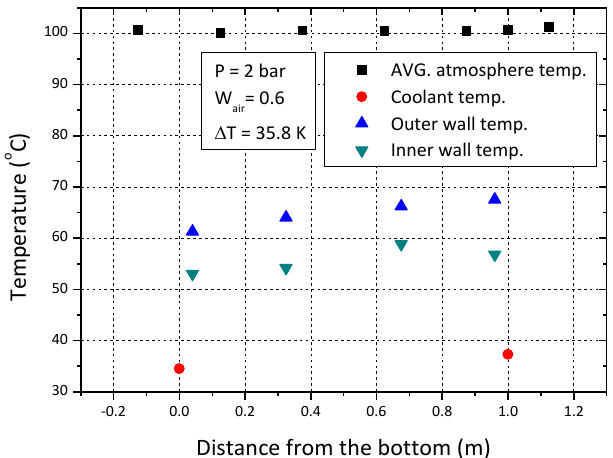
Figure 9. Typical temperature distribution during the experiment when air mass fraction is 0.6 at 2 bar.